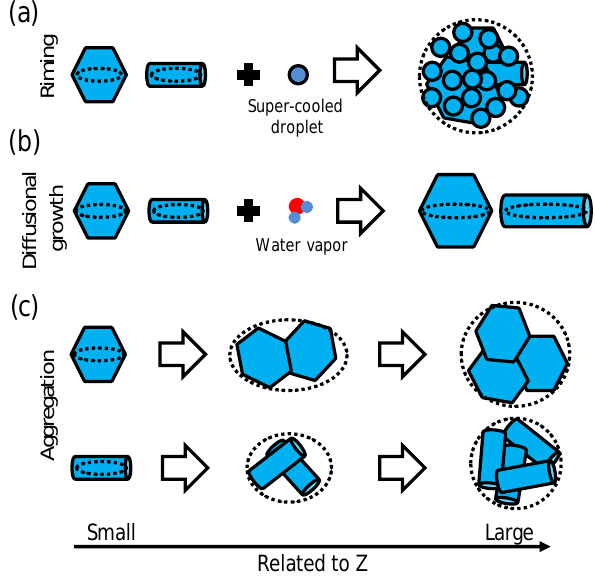
Figure 2. Sketch of ice particle growth processes within mixed- phase clouds. In panel (a) riming of ice crystals is depicted. Panel (b) shows the diffusional growth of ice crystals and (c) the aggregation of ice crystals. The hexagonal plates and cylindrical columns represent either plate and dendrite shape or needles and columns, respectively. Size growth is indicated with bigger parti- cles in the sketch. In the measurements an increase in particle size is related to an increase in Z values, indicated by the arrow at the bottom. The particle shapes are indicated by the dotted ellipses (the particles are modeled as